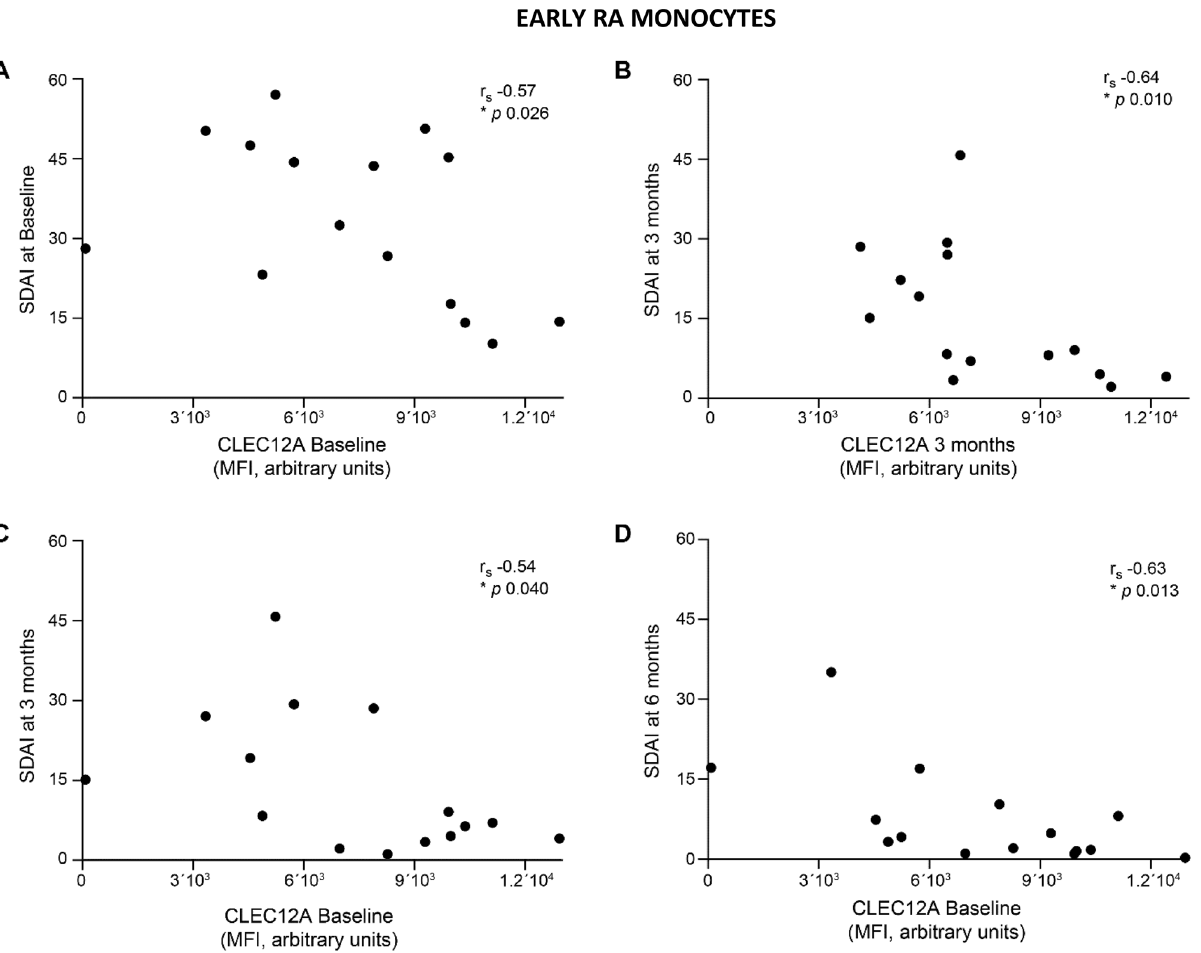
Figure 2. Monocyte CLEC12A expression in eRA patients correlates with SDAI. Cell-surface, CLEC12A expression was determined by flow cytometry on peripheral monocytes. Cross-sectional correlations between monocyte CLEC12A expression in eRA patients and SDAI score at (A) baseline, and (B) three months. Correlations between baseline, monocyte CLEC12A expression and SDAI at (C) three months and (D) six months. Statistical analysis: Spearman’s rank correlation coefficient and p value are shown in each panel. Symbols represent individual